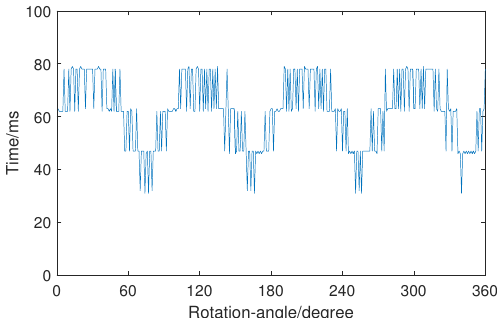
Figure 8. Time consumption of rotation-angle measurement when the rotation angle is 1 ◦ –360 ◦